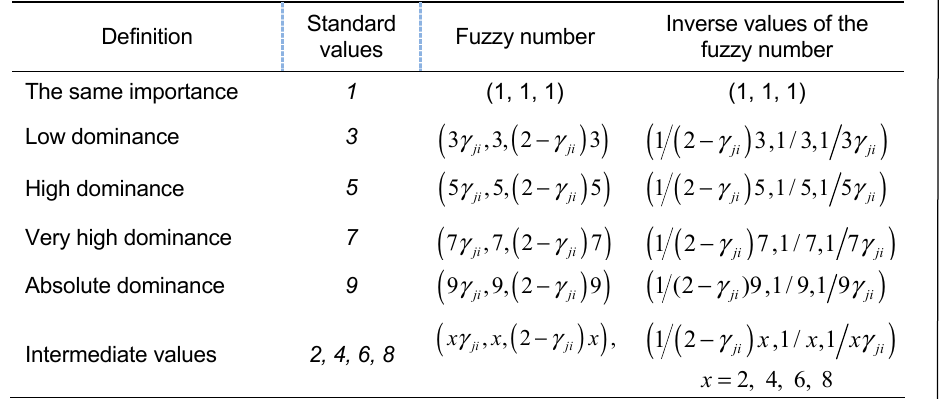
Table 2 – Fuzzified Saaty's scale for comparison in pairs (Božani ć , Pamu č ar), (Božani ć , et al., 2015a), (Božani ć , et al., 2016) Таблица 2 – Фаззифицированная шкала Саати парных